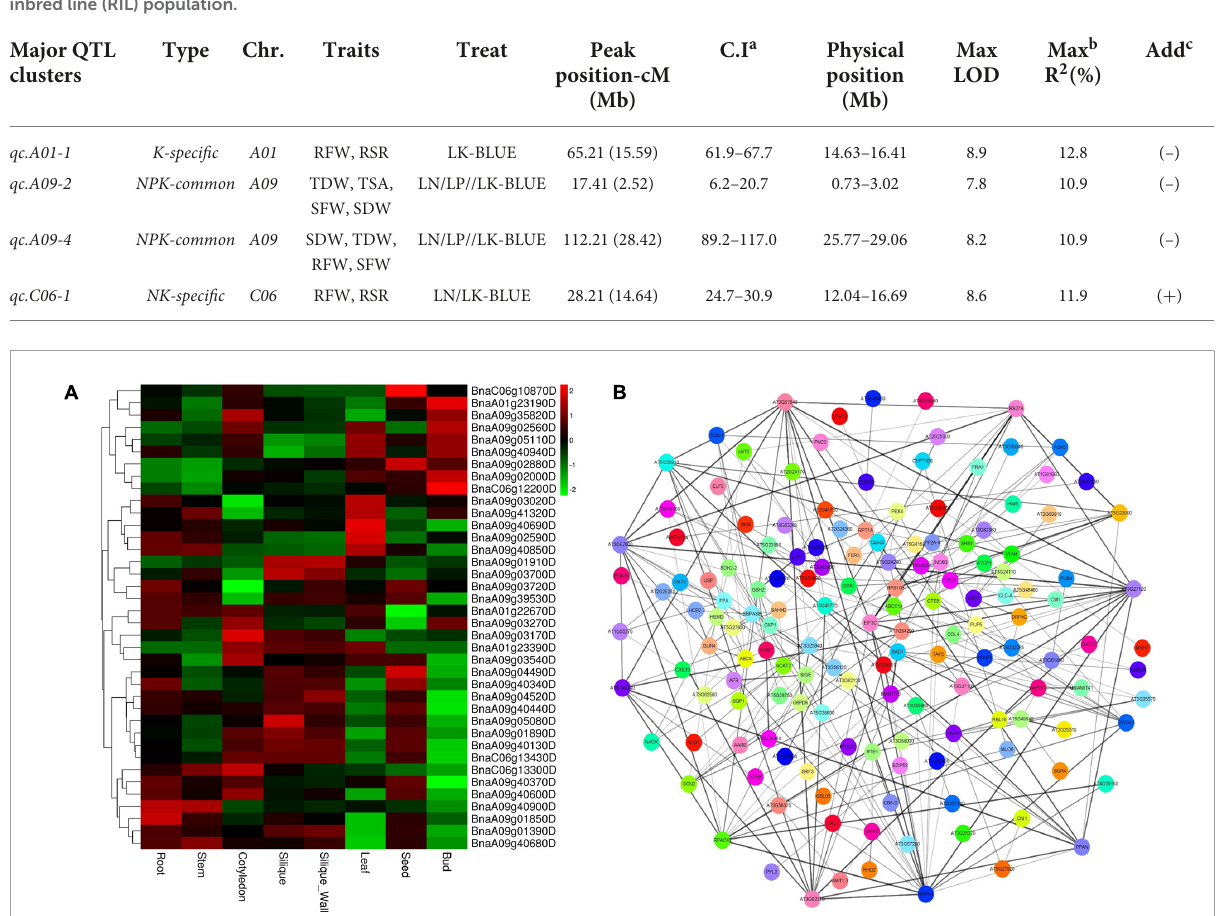
FIGURE5 Heat map and protein interaction network analysis for the candidate genes within the major quantitative trait loci (QTL) clusters. (A) Expression profiles of candidate genes in eight distinct tissues; Heat map is based on the log 2 (TPM + 1 ) values. (B) Protein interaction network analysis.